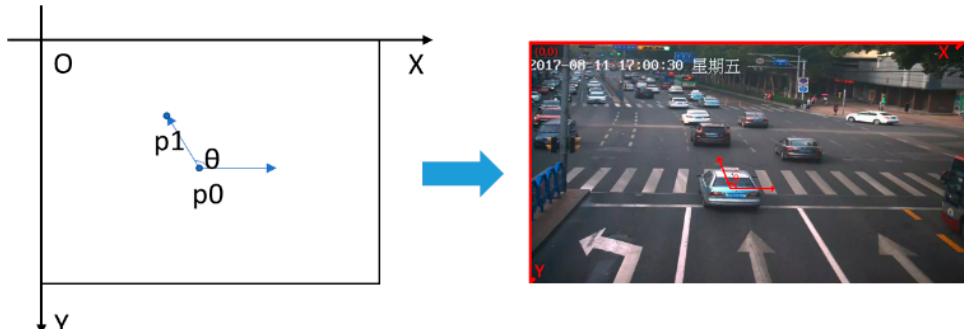
Figure 4. Construction of coordinate system and calculation of the included angle.